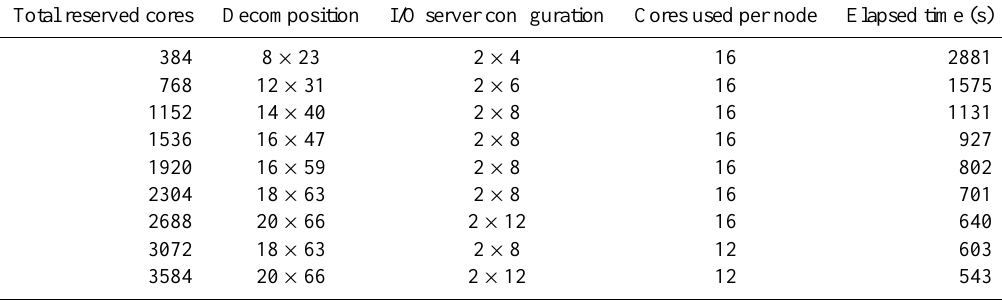
Table 2. The best elapsed times for N512L70 on Raijin using 2 threads.